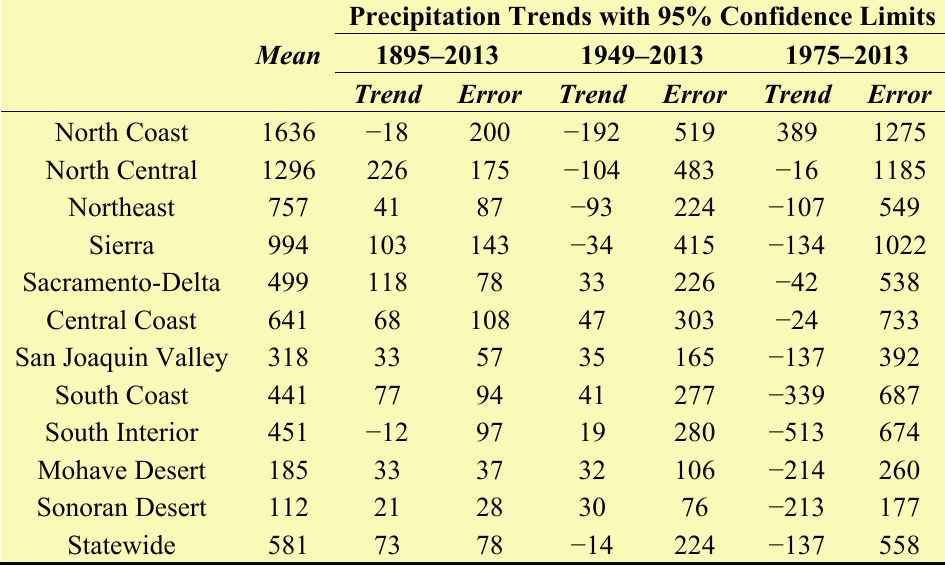
Table 1. Annual rainfall trends over different periods based on the eleven California climatic regions in mm per 100 years. Values in blue represent significant trends.